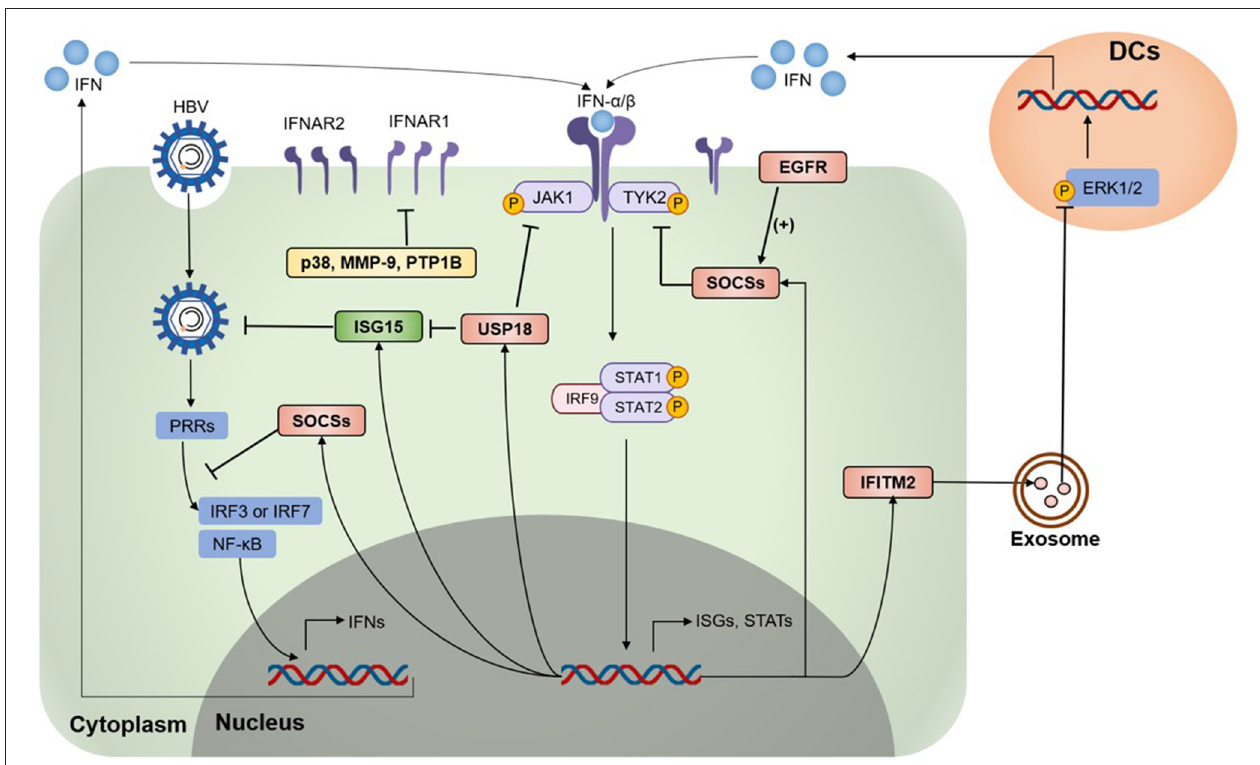
FIGURE 1 | Type I IFN signaling is down-regulated by negative regulators. Various negative regulators cross-regulate the type I interferon (IFN) response, which modulates the expression levels and activation states of IFN signaling components. On HBV infection and invasion, pattern-recognition receptors (PRRs) recognize HBV and activate the downstream pathway to induce IFN expression. IFNAR1/2 recognize type I IFN and activate Janus kinases 1 (JAK1) and tyrosine kinase 2 (Tyk2), followed by the activation and phosphorylation of signal transducer and activator of transcription factors (STATs), leading to the expression of various IFN-stimulated genes (ISGs). Several ISGs were identified as negative regulators of the IFN signaling pathway, including the suppressor of cytokine signaling (SOCS) proteins, ubiquitin-specific protease 18 (USP18), Interferon-induced transmembrane protein 2 (IFITM2), p38 mitogen-activated kinases (p38 MAPKs), matrix metalloproteinase 9 (MMP-9), epidermal growth factor receptor (EGFR), protein tyrosine phosphatases 1 B (PTP1B), and some regulators awaiting exact mechanisms. HBV, hepatitis B virus; IRF3, IFN regulatory factor 3; IRF7, IFN regulatory factor 7; ERK1/2, extracellular signal-regulated kinase 1/2; DCs, dendritic